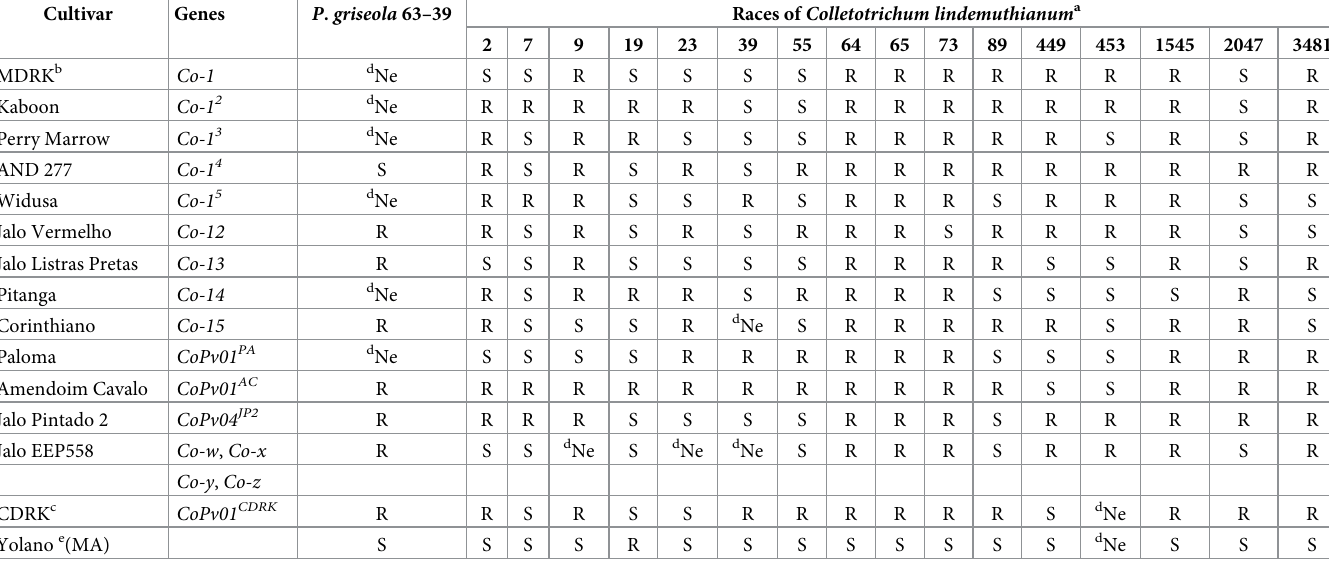
Table 1. Resistant (R) or Susceptible (S) reactions of 15 Phaseolus vulgaris cultivars to nine Mesoamerican (9, 65, 73, 89, 445, 453, 1545, 2047, and 3481) and six Andean (2, 7, 19, 23, 39, and 55) races of C . lindemuthianum and race 63–39 of P . griseola .